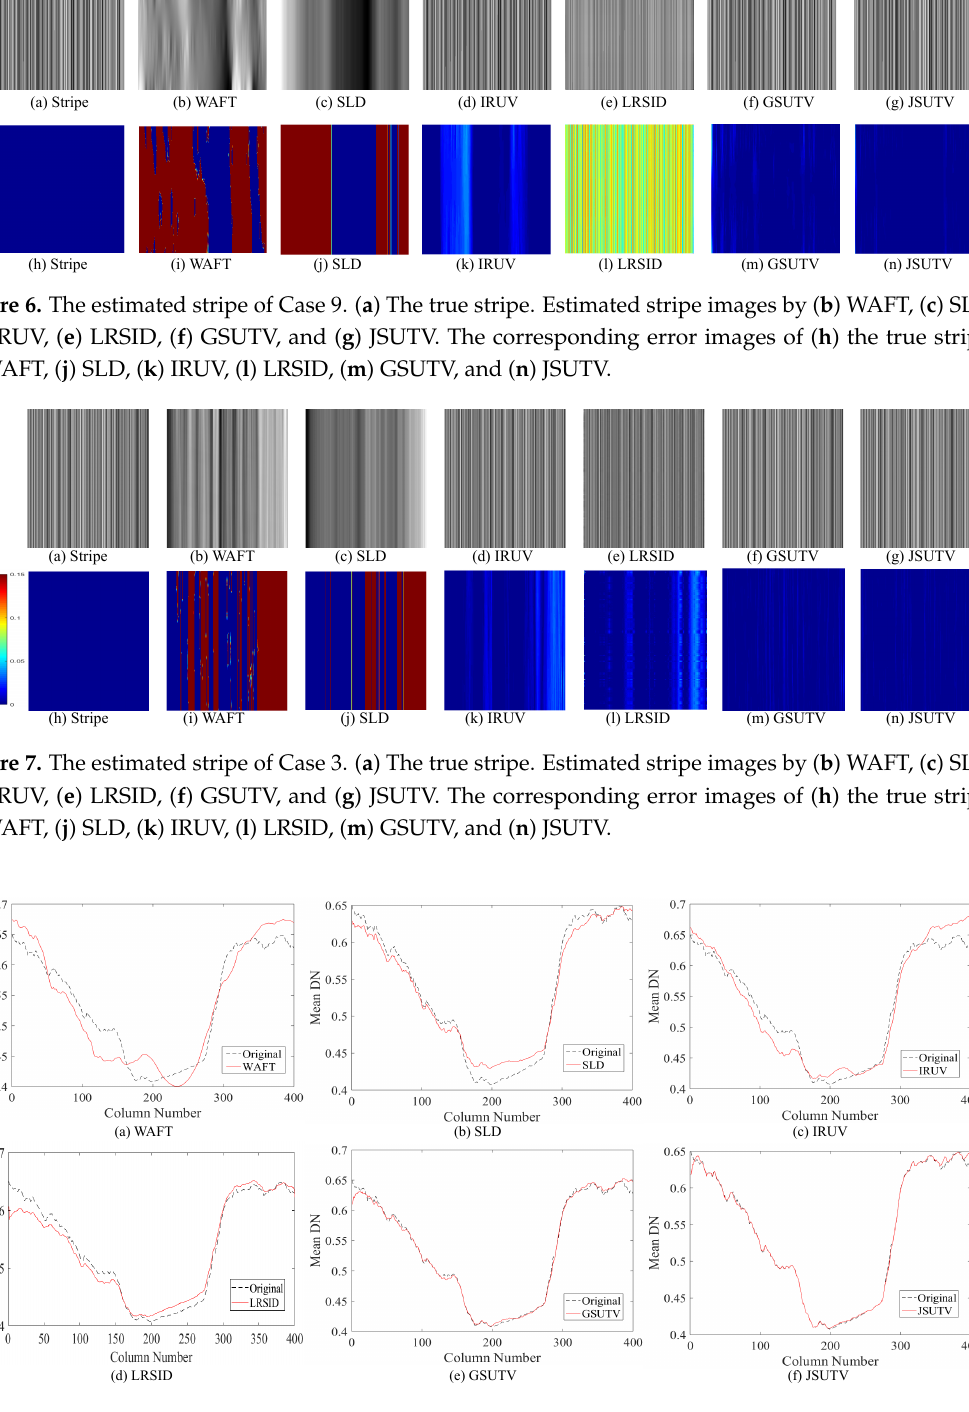
Figure 8. Column mean cross-track profiles of Figure 4. Column mean cross-track profiles’ comparison between the original image and the estimated stripe by: ( a ) WAFT; ( b ) SLD; ( c ) IRUV; ( d ) LRSID; ( e ) GSUTV; and ( f )